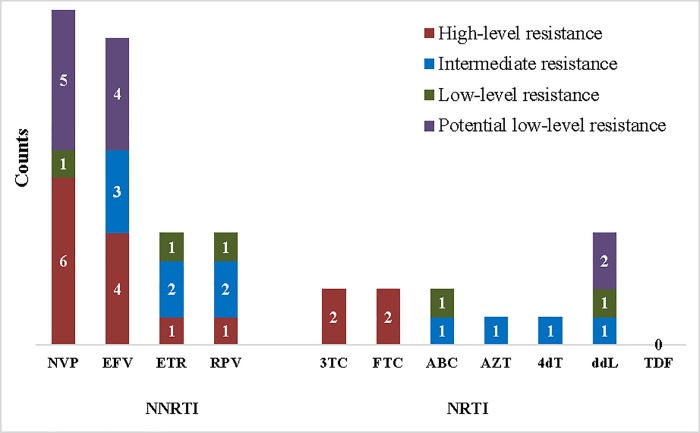
Frequency and levels of HIV-1 drug resistance to various antiretroviral drugs among ART-naïve patients.NRTI: Nucleotide reverse transcriptase inhibitors [3TC: lamivudine; FTC: emtricitabine; ABC: abacavir; AZT: zidovudine; d4T: stavudine; ddl: didanosine; TDF: tenofovir]. NNRTI: Non-Nucleoside reverse transcriptase inhibitors [NVP: nevirapine; EFV: efavirenz; ETR: etravirine; RPV: rilpivirine]. Red represent high-level resistance, blue represent intermediate resistance, green represent low-level resistance and purple represent potential low-level resistance.